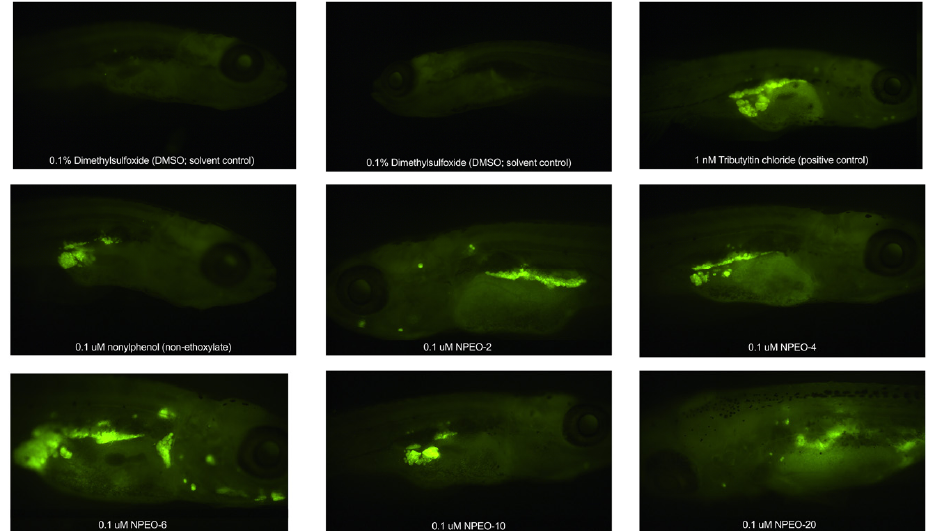
Figure 6. Adipose Patterning in Zebrafish Developmentally Exposed to Nonylphenol and Polyethoxy- lates. Representative fluorescent images of developmentally exposed zebrafish exposed to con- trol chemicals, nonylphenol, and the nonylphenol polyethoxylates. Anesthetized fish imaged at 30 days post-fertilization, following a 30 min stain (0.5 µ g/mL Nile Red). Images obtained at 16 × magnification using a yellow fluorescent protein filter. DMSO = dimethylsulfoxide, vehicle control; TBT = tributyltin chloride; NPEO = nonylphenol polyethoxylated (with varying average ethoxylate chain